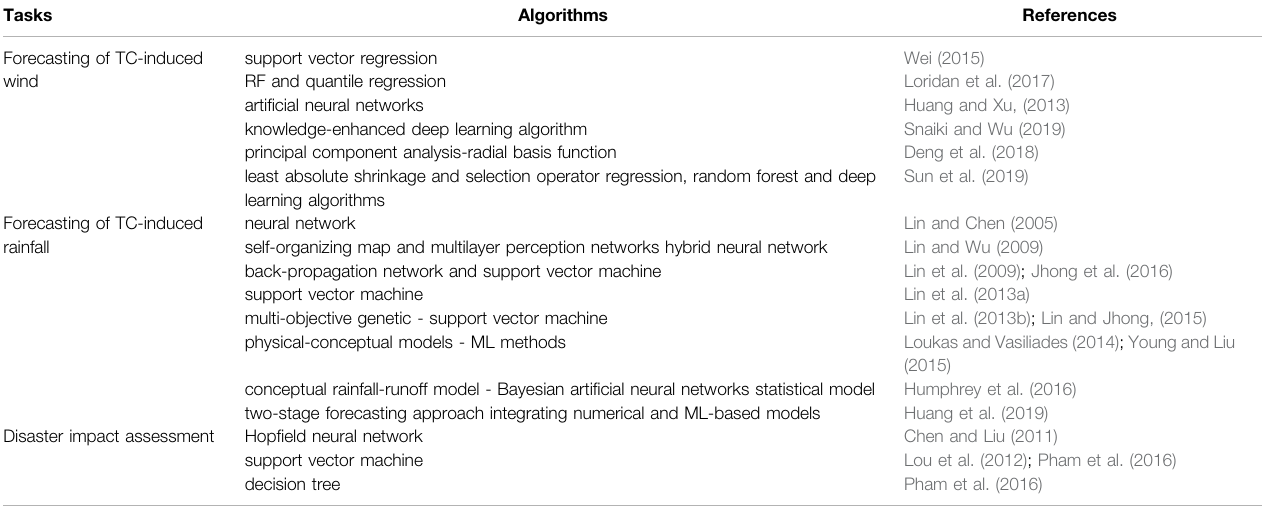
TABLE 4 | Application of machine learning in the forecasting of TC-induced disastrous weather and its impact. Tasks